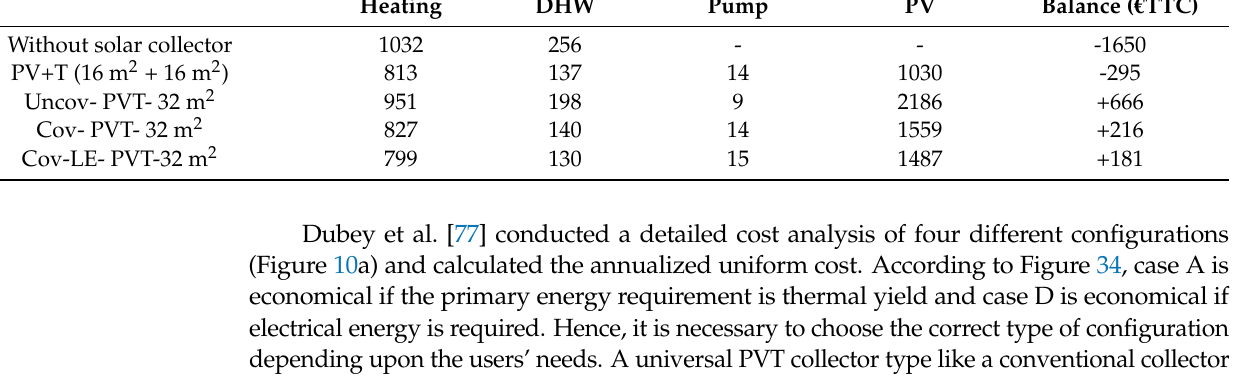
Table 2. Annual financial costs and benefits including auxiliary system (electrical) (Data from [76], with permission from publisher). Heating DHW Pump PV Balance ( €